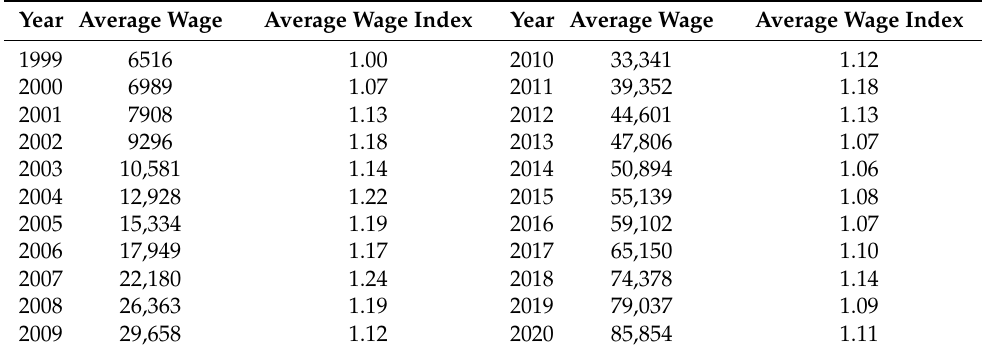
Table 5. Average wages in Anhui Province from 1999 to 2020. Year Average Wage Average Wage Index Year Average Wage Average Wage